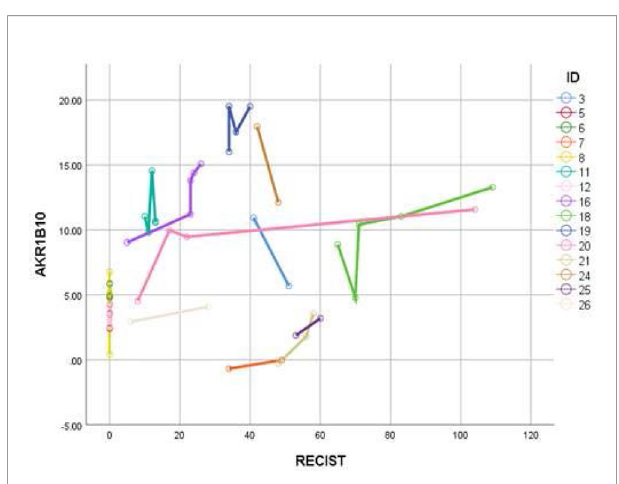
FIGURE 7 | AKR1B10 levels did not show any correlation with RECIST scores. Higher RECIST scores suggest high disease burden and vice versa. Data suggest that serum AKR1B10 may not be used for monitoring disease activity or response.